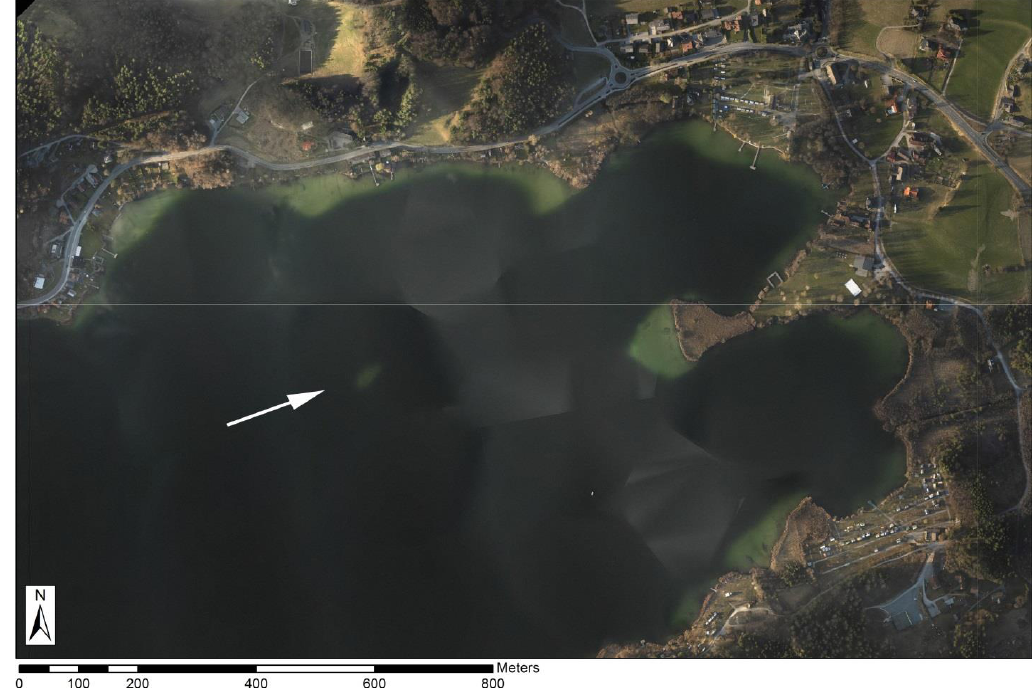
Figure 4. Case study area of Lake Keutschach. Simultaneously acquired orthophoto mosaic. The arrow hints at the oval shaped shallowness, where the late Neolithic lake dwelling is